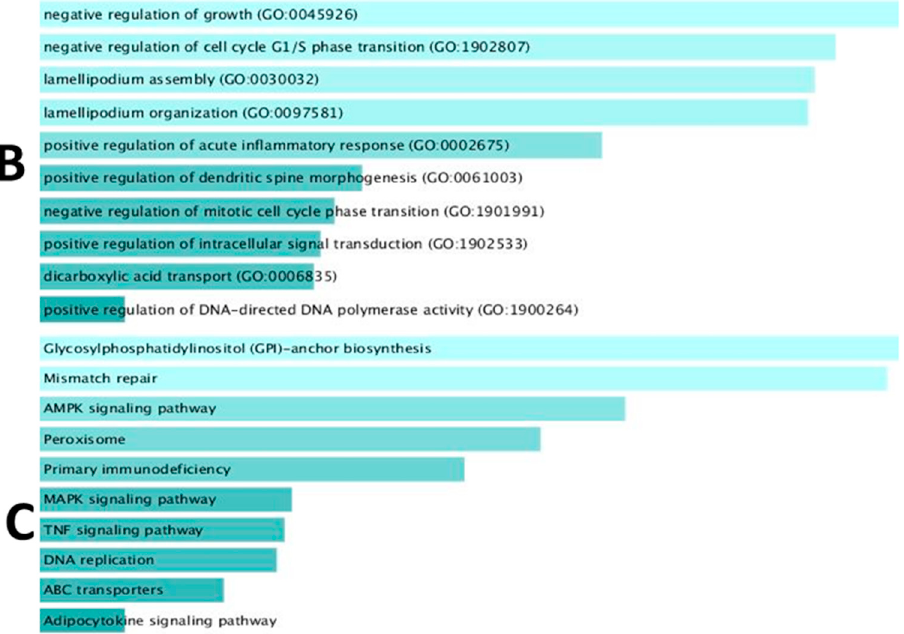
Figure 1. ( A ) Heat map of differentially expressed genes in GSE89632. The co-expression matrix was represented by a heatmap graphed by heatmap R (Version 3.6.3) built function. Beige color represents down regulation while brick-red color represents upregulation. ( B ) Top 10 items of Gene Ontology (Biological processes) for the retrieved DEGs according to p value obtained from Enrichr. ( C ) Top 10 items of KEGG pathways for the retrieved DEGs according to adjust p value obtained from Enrichr.